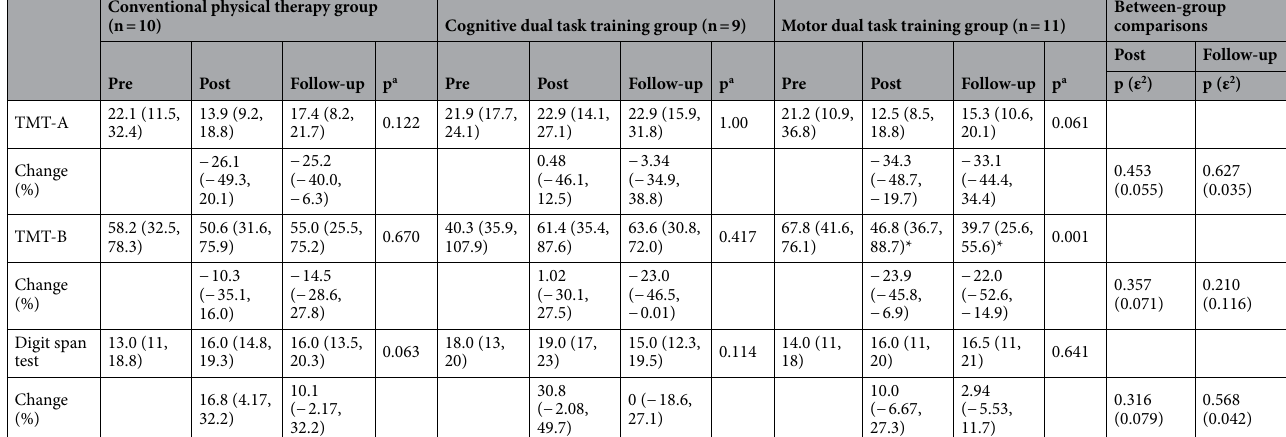
Table 5. Comparisons of cognitive function after training at different time point. Values are median (interquartile). Change values were calculated by (post data or follow-up data − pre data) / pre data × 100% TMT Trail-Making Test. a p value for within-group comparison using Friedman test. *p < 0.05 for within group difference compared to